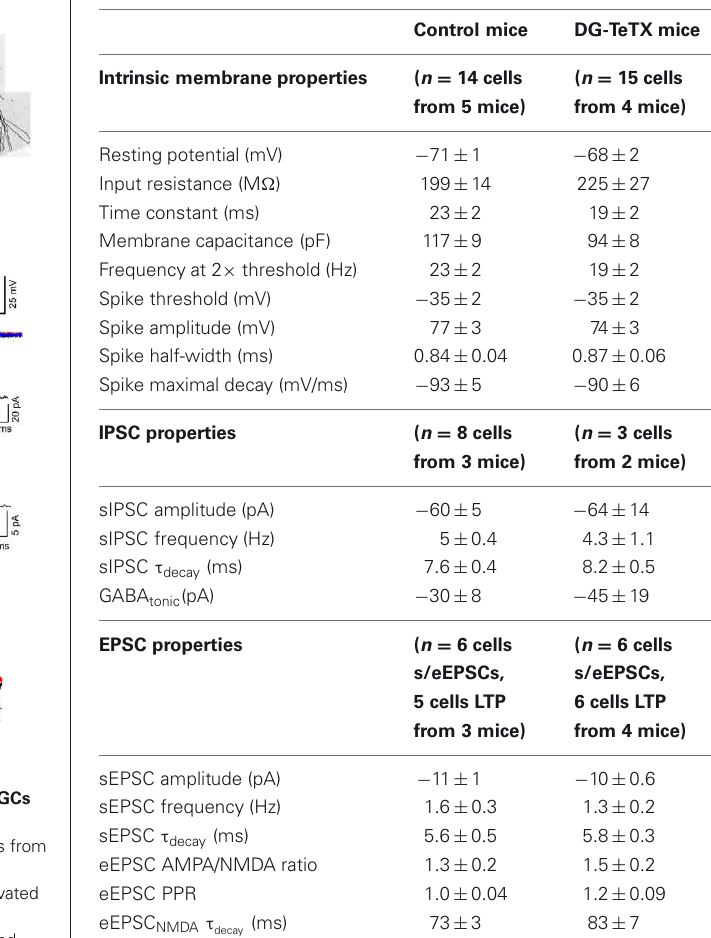
Table 1 | Summary of electrophysiological properties of mature granule